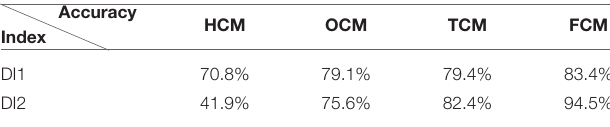
TABLE 4 | Accuracy of damage location identification according to the statistical results.